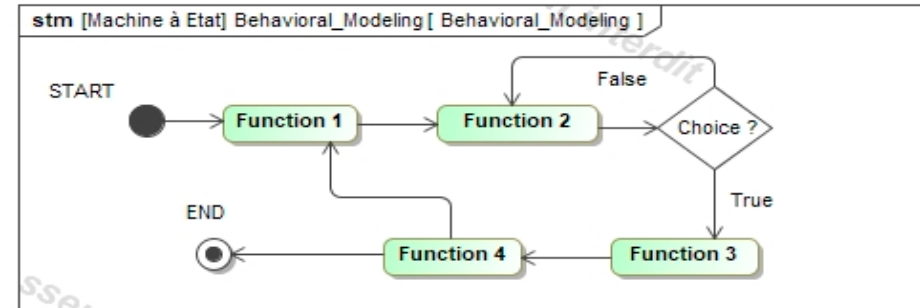
Figure 4. Abstract model of collective behavior in SysML.